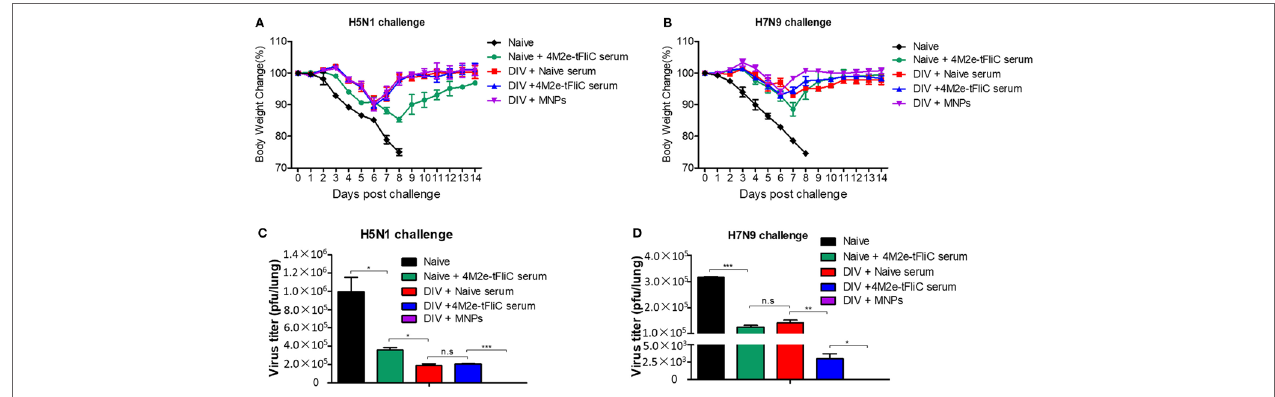
FigUre 6 | 4M2e-tFliC microneedle patch (MNP) immune sera play a protective role in heterologous virus infection. BALB/c mice ( N = 5) were intramuscular (IM) immunized twice with the divalent inactivated vaccine (DIV). One group of immunized mice was boosted with 4M2e-tFliC MNPs for the third immunization (DIV + MNPs). Three weeks after the MNP vaccination, the other two groups of DIV-immunized mice were intraperitoneally (IP) injected with naïve serum (DIV + Naïve serum) or 4M2e-tFliC immune serum (DIV + 4M2e-tFliC serum), respectively. Naïve mice received 4M2e-tFliC immune serum as a control (Naïve + 4M2e-tFliC serum). (a,B) Body weight change after 2 × LD 50 of A/Vietnam/1203/2004 (H5N1, rVet) and A/Shanghai/02/2013 (H7N9, rSH) reassortant virus challenges. (c,D) Lung viral titers at day 5 post H5N1 and H7N9 challenges. Data represent mean ± SEM. The statistical significance was analyzed by Student’s t -test. * p < 0.05, ** p < 0.01, *** p < 0.001, n.s p >